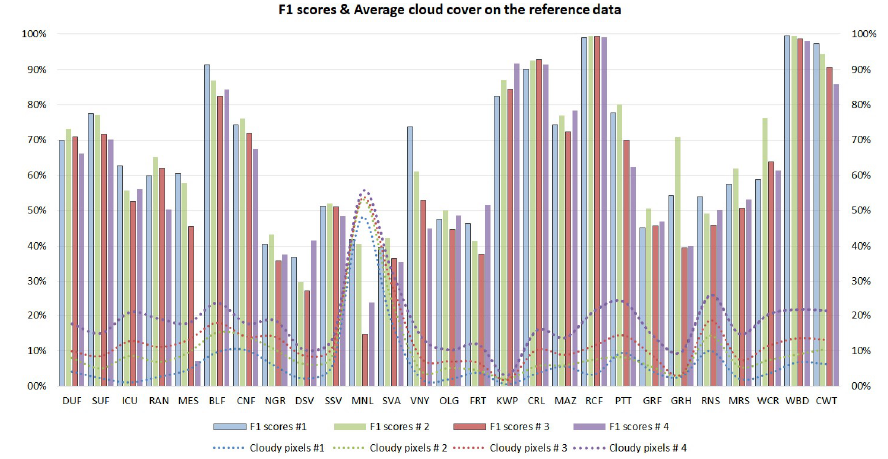
Figure 7. The per-class F1 scores (%) are illustrated in the bar chart for every dataset. The average per-class cloud cover (%) of the reference data are illustrated with dotted lines for every